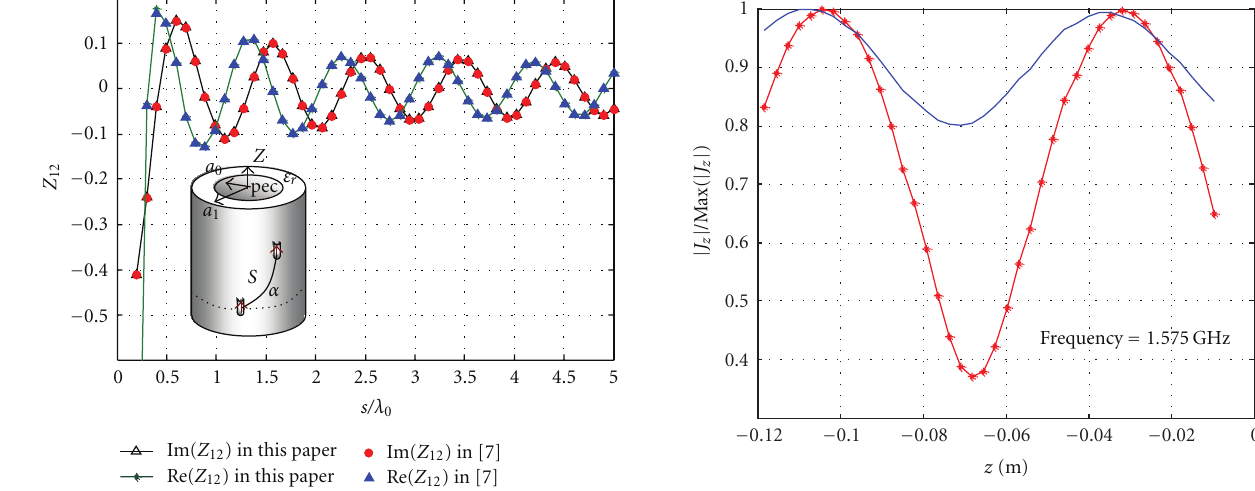
Figure 7: Real and imaginary parts of the mutual impedance ( Z 12 ) between two identical z - directed current sources versus separation S when α = 90 ◦ (axial line problem).